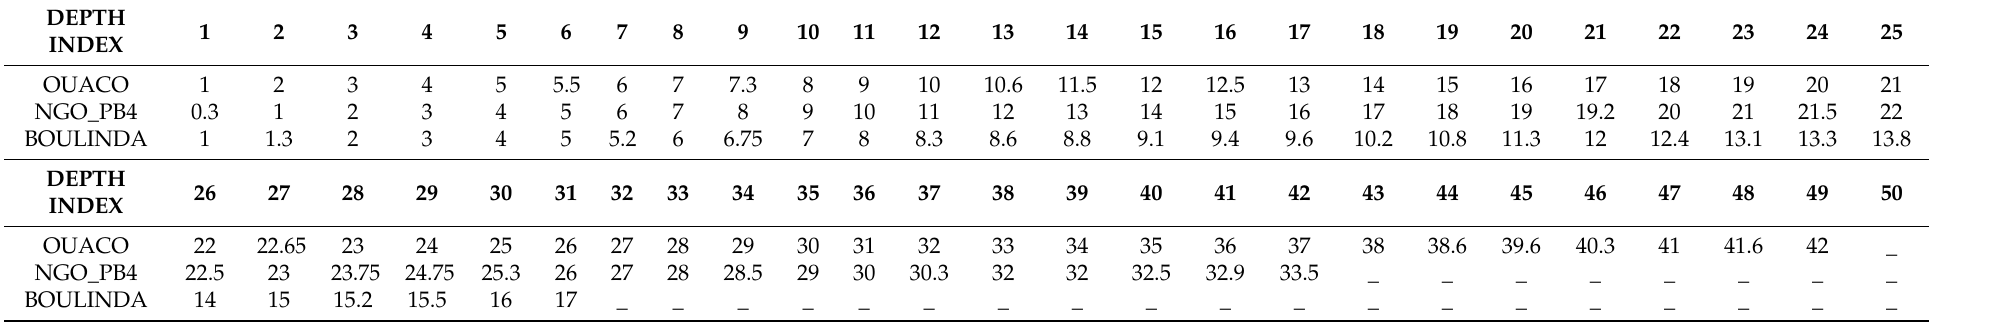
Table 2. The depth indices and corresponding actual depths in metres for each